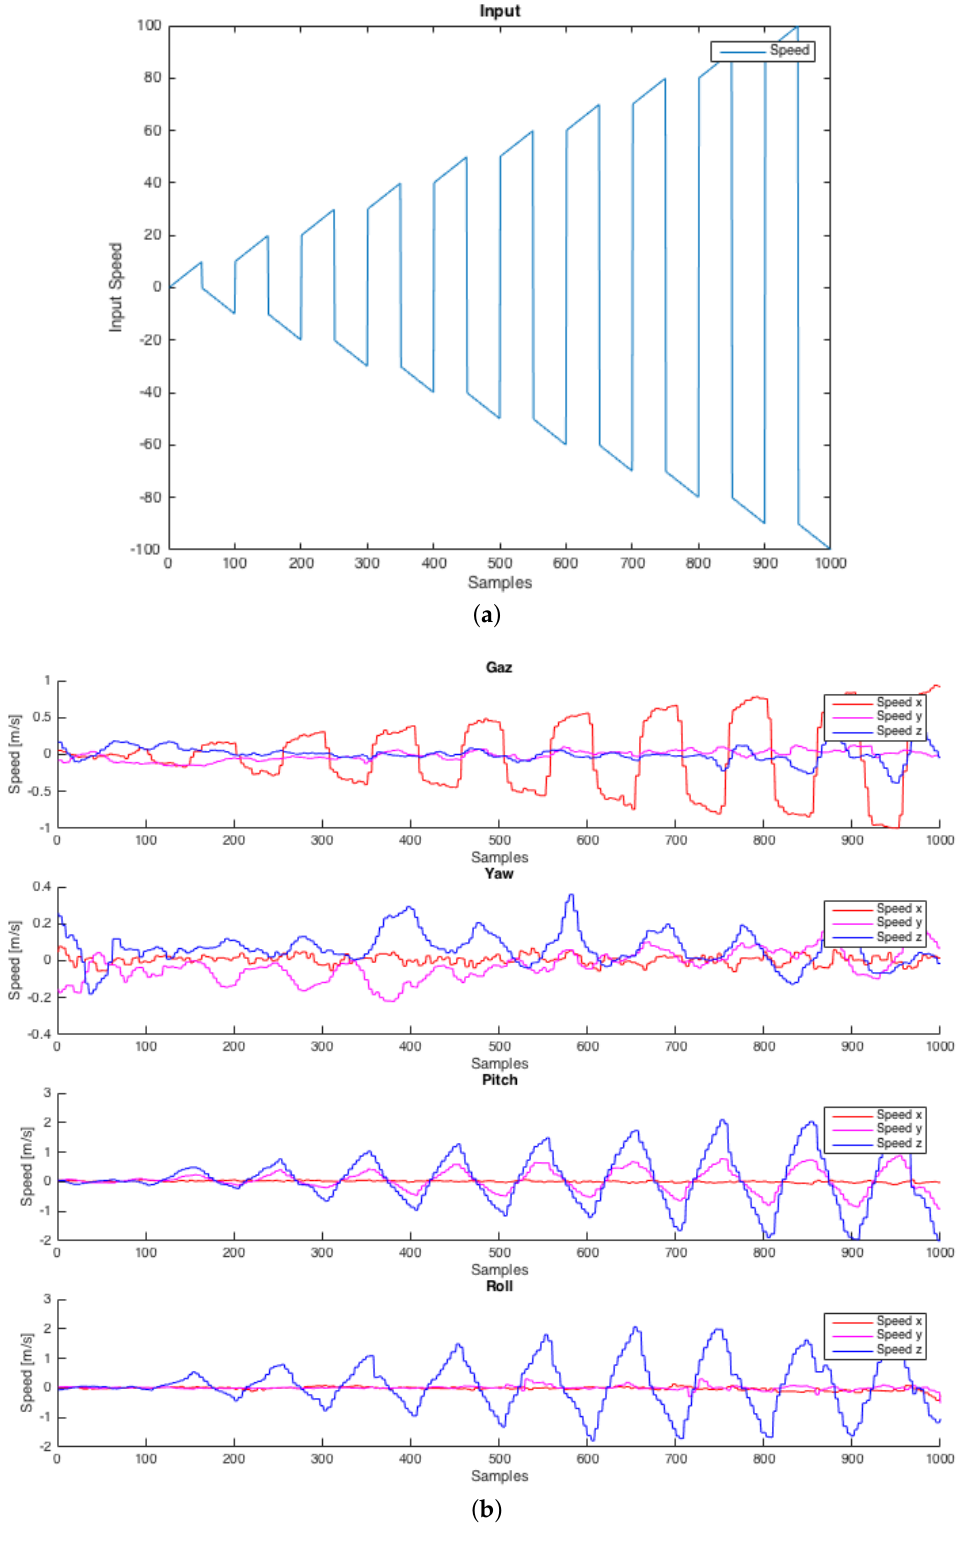
Figure 7. System behavior for different input values. ( a ) Speed-input; ( b ) speed-output in the x -axis, y -axis and z